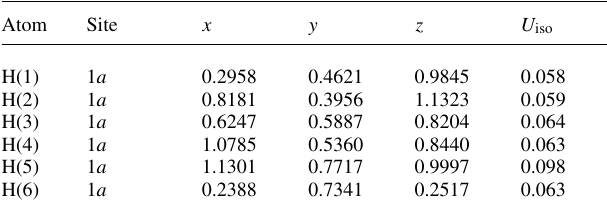
Table 2. Atomic coordinates and displacement parameters (in Å 2 )